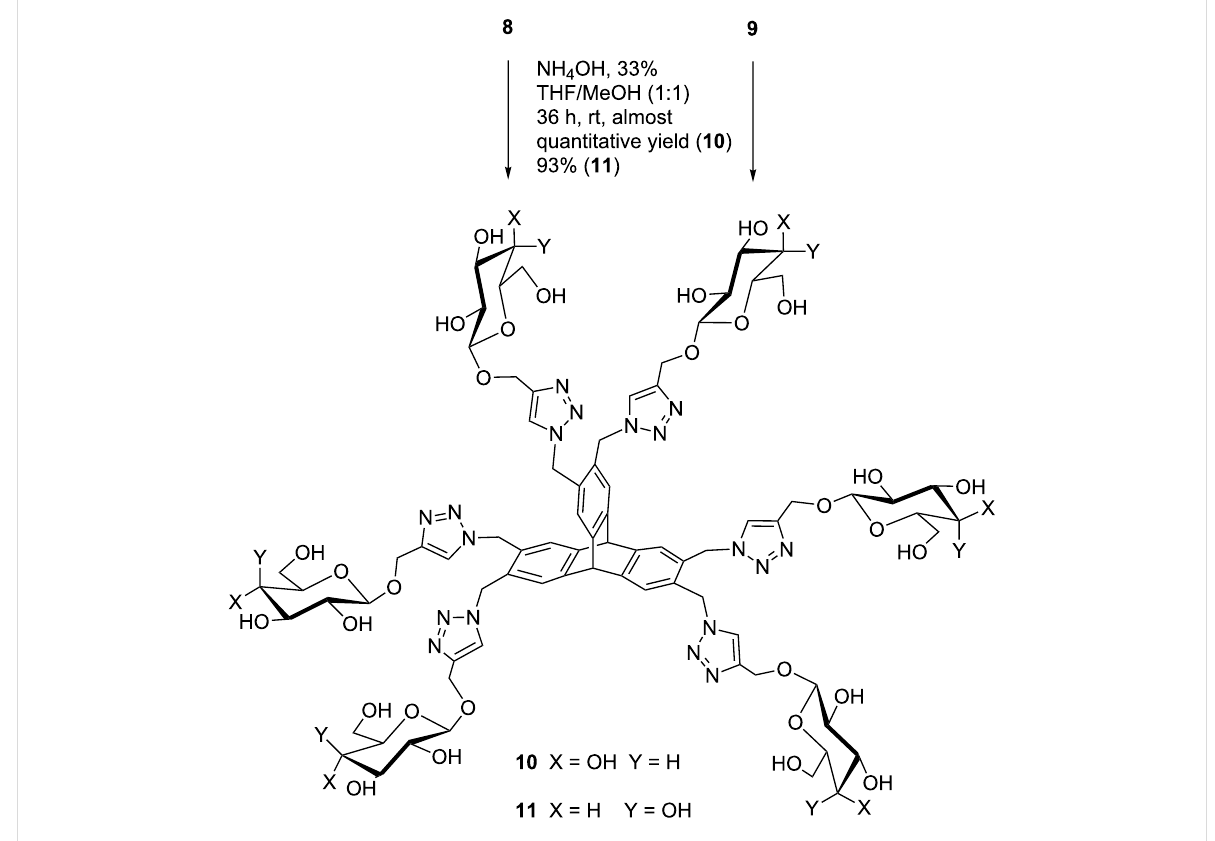
Scheme 3: Deacetylation of target compounds 8 and 9 to 10 and 11,